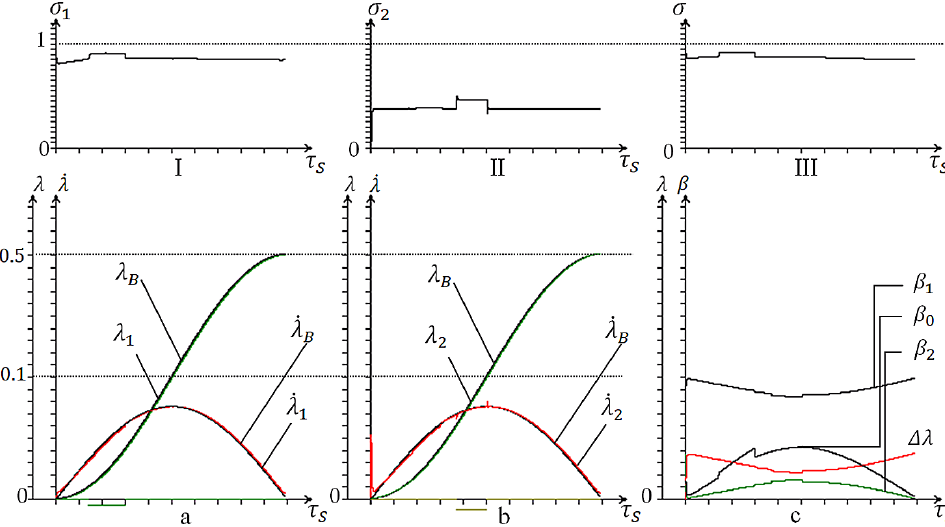
Figure 12. Estimated dynamic characteristics of the solution